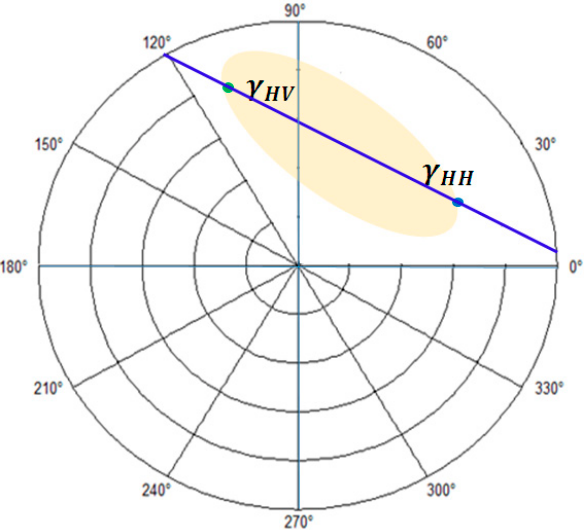
Figure 5. The coherence region in the CUC for a dual-polarization pixel.